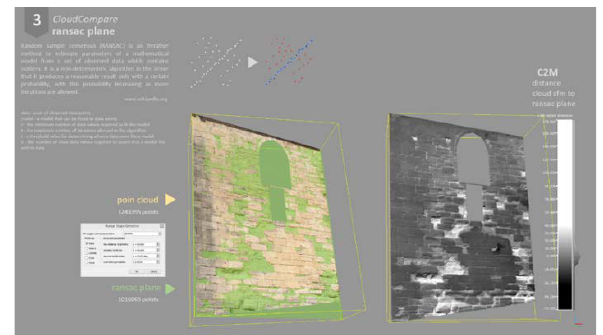
Figure 8. Creazione del piano Ransac e della mappa di scostamento dal piano.